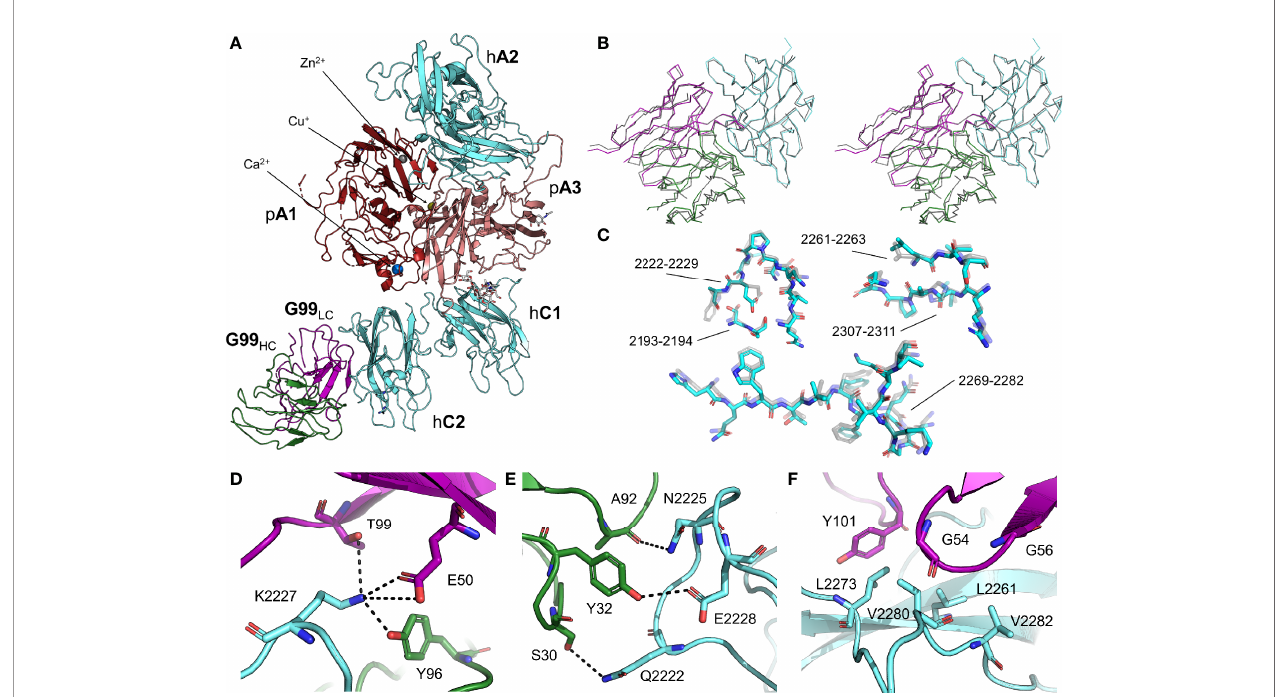
FIGURE 1 | Crystal structure of ET3i bound to the G99 F AB fragment. (A) Cartoon representation of the B domain deleted bioengineered fVIII construct (ET3i) bound to the variable domain of G99 inhibitor antibody. Porcine A1 and A3 (pA1 and pA3) domains are colored dark red and pink, respectively, and human A2, C1, and C2 (hA2, hC1, and hC2) domains are colored cyan. Heavy and light chains of the G99 F AB fragment (G99 HC and G99 LC ) are colored green and purple, respectively. N-acetylglucosamine modi fi cations are depicted as sticks. (B) Ribbon diagram of aligned C2 domain (cyan) and G99 heavy and light chains (green and purple, respectively) from the ET3i:G99 crystal structure and of the isolated C2 domain bound to G99 (grey; PDB ID: 4KI5) in stereo view. (C) Stick representation of the G99 epitope from the ET3i:G99 (cyan) and C2:G99 (grey, faded) crystal structures. (D, E) Electrostatic contacts between ET3i epitope 2222-2229 (cyan) and G99 heavy chain (green) and light chain (purple). Dotted lines depict hydrogen bonds (distance ≤ 5 Å). (F) Hydrophobic residues along the ET3i epitope 2269-2282 (cyan) buried by the G99 light chain